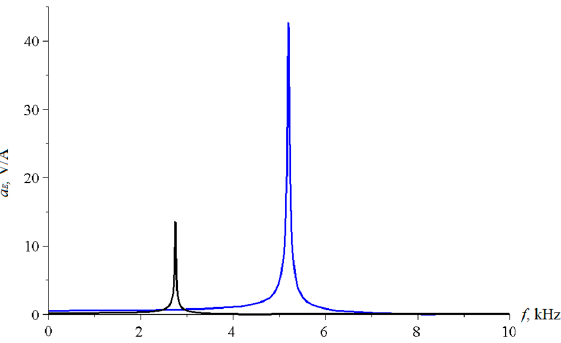
Figure 7. Theoretical dependence of the ME voltage coefficient on the frequency of the alternating magnetic field. Black color of the line is PZT, blue is LN cut y + 128°. magnetic field. Black color of the line is PZT, blue is LN cut y + 128 ◦